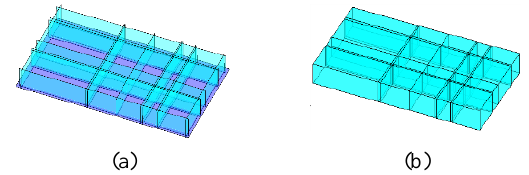
Fig. 2 An illustration of 3D decomposition of an interior space: (a) intersection between horizontal and vertical structures (the ceiling plane has been removed for a better visualization), (b) the 3D decomposition.